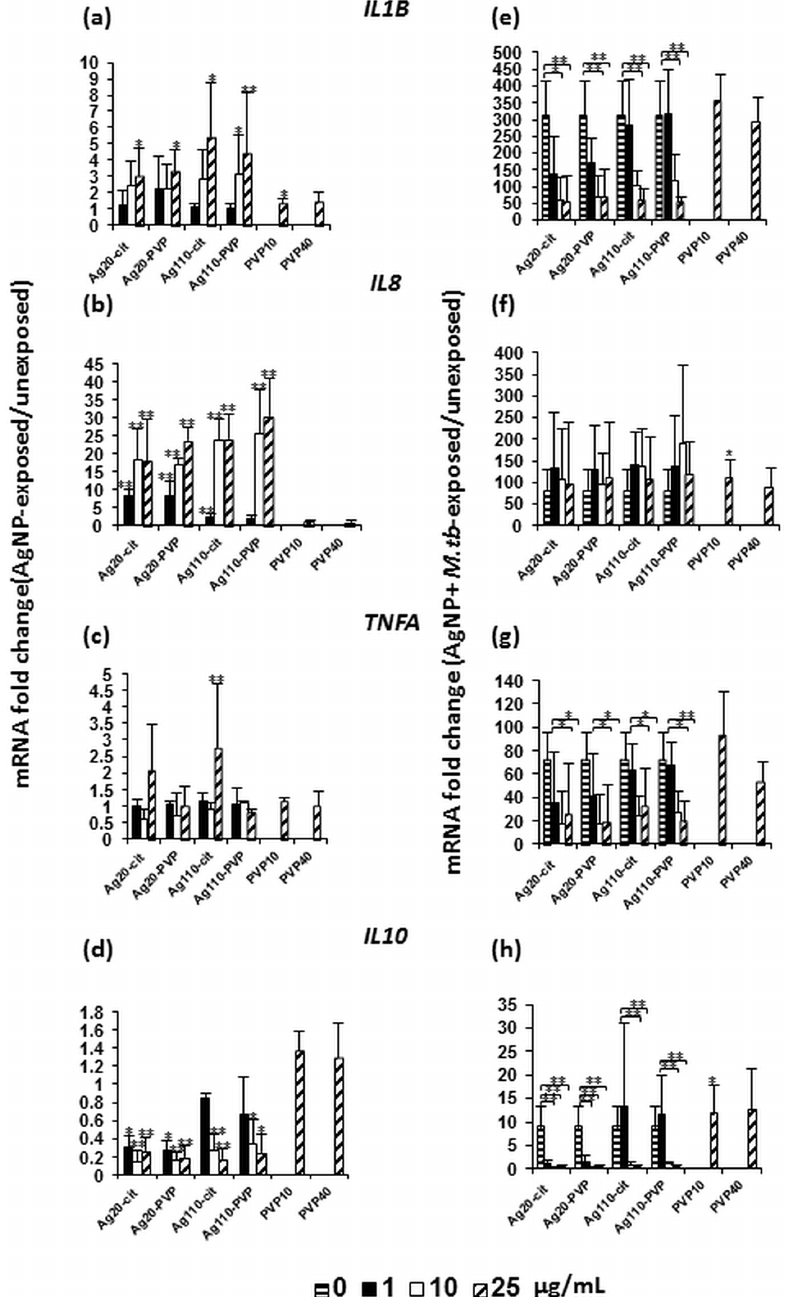
Fig 4. Effect of AgNP on cytokine mRNA expression by MDM in the absence and presence of M . tb . MDM from four healthy human blood donors were exposed to 0, 1, 10 and 25 μ g/mL of Ag20-citrate, Ag20-PVP, Ag110-citrate, Ag110-PVP and 1.7 μ g/mL PVP10 and 3.1 μ g/mL PVP40 in the absence ( a , b , c and d ) or presence ( e , f , g , and h ) of M . tb (MOI 10) for 4 hours at 37°C in a humidified 5% CO 2 environment. Following incubation, RNA was extracted and the abundance of mRNA encoding IL1B , IL8 , TNFA and IL10 examined by qRT-PCR using gene-specific primer sets as described [28]. For primer sequences see Materials and Methods. Results are shown as fold-changes relative to controls (MDM in culture media without AgNP (0 μ g/mL) in a-h . In panels e-h , 0 μ g/mL data points represent MDM exposed to M . tb MOI 10 in absence of AgNP. Each data point (Y-axis) represents mean fold-changes ± SD from four independent experiments. Statistically significant changes relative to unexposed MDM are marked by * ( p < 0.05) or ** ( p <